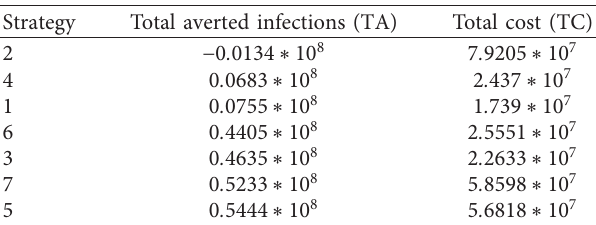
u k . (b) The optimal control Table 2: Total costs and total averted infections for all